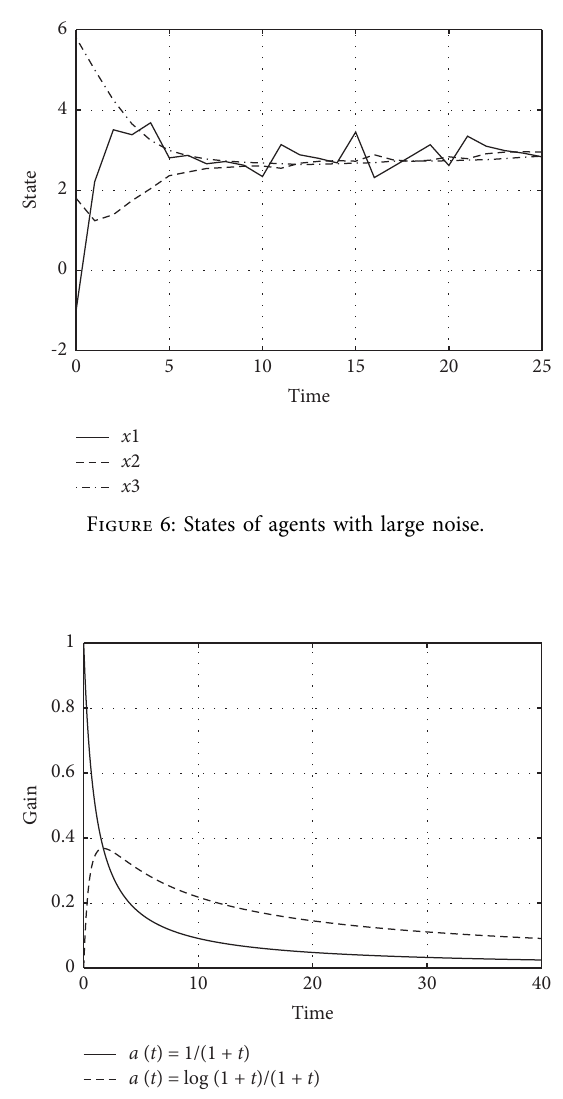
Figure 7: Trajectory of mandatory